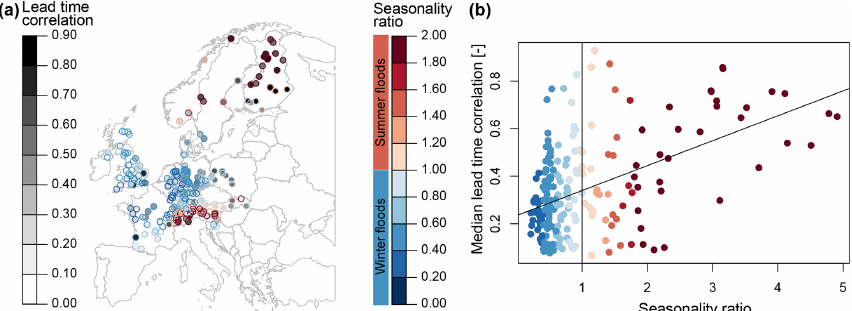
Figure 6. Median annual maxima dependence across all lead times and ensemble members per catchment. (a) Spatial variation in median correlation (grey outlines) and seasonality ratio, where red colours indicate higher floods ( Q 95 ) in summer than winter and blue colours indicate higher floods in winter than summer. (b) The relationship between the median correlation and seasonality ratio, where the vertical black line indicates the transition from winter- to summer-dominated flood regimes, and the trend line was derived using linear regression.